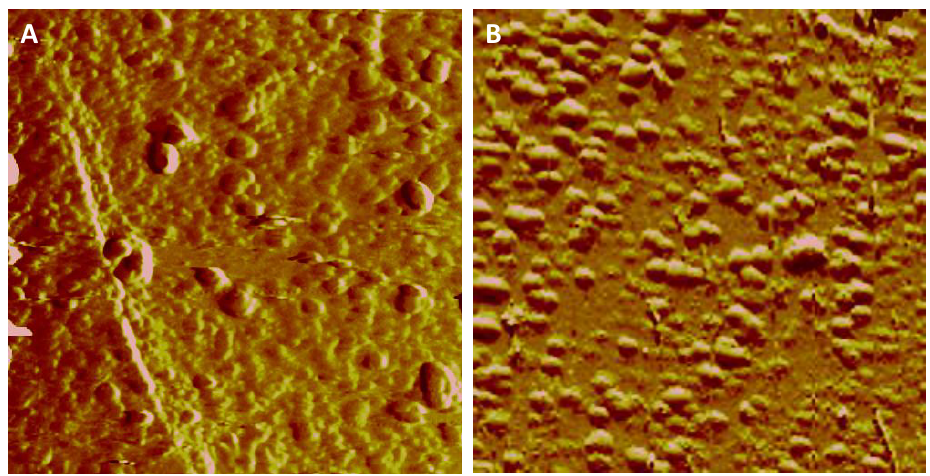
Figure 2. Ex situ AFM images of the same ( A ) hematite and ( B ) goethite substrate as the above (Figure 1), reacting in solutions (50 mM NH 4 H 2 PO 4 , pH 4.5) for 3 days at room temperature.